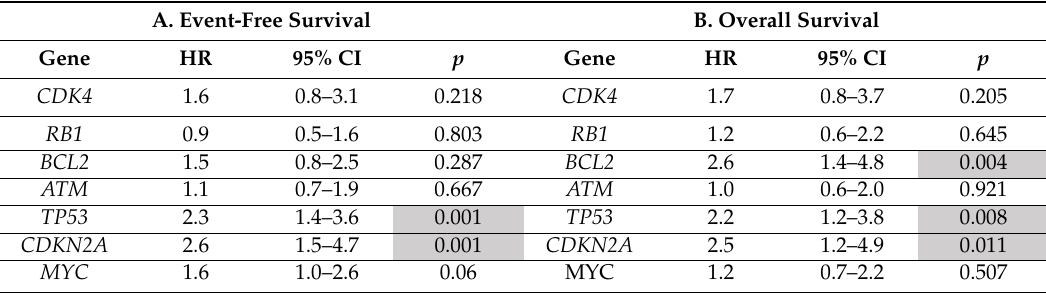
Table 3. E ff ect of the analyzed gene aberrations with survival parameters: multivariate analysis. ( A ) Event-Free Survival; ( B ) Overall